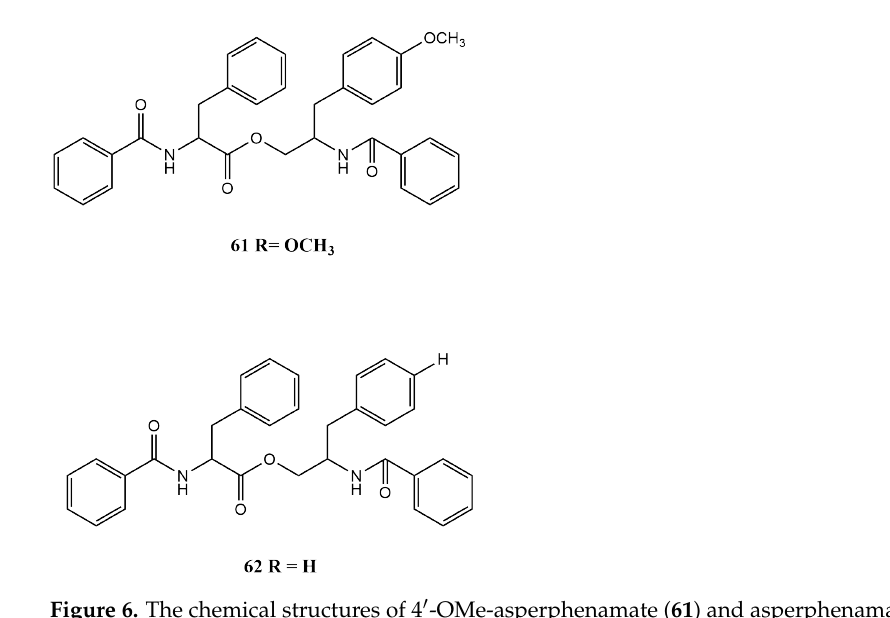
Figure 6. The chemical structures of 4 (cid:48) -OMe-asperphenamate ( 61 ) and asperphenamate ( 62